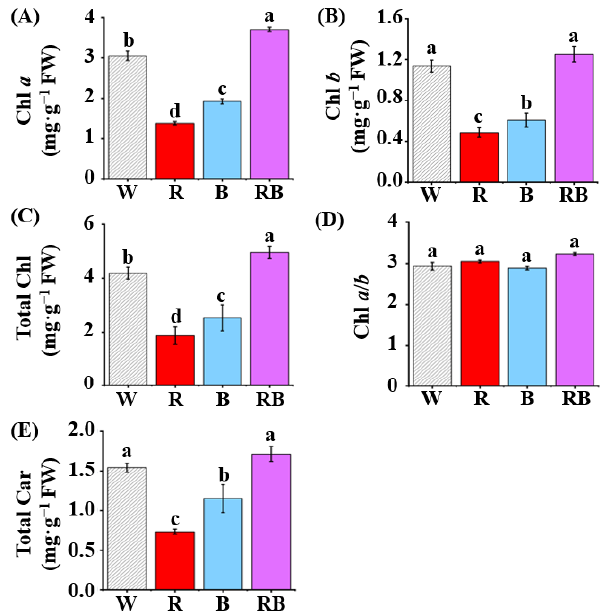
Figure 3. Effect of light quality on contents of chlorophyll a ( A ) and chlorophyll b ( B ), total chlorophyll ( C ), chlorophyll a / b ratio ( D ), and content of total carotenoids ( E ) in leaves of C. triste plantlets after four weeks of culture: The light qualities used were W, white LED; R, red LED; B, blue LED; and RB, combined red and blue LEDs in a 1:1 ratio. The results were expressed as means ± standard errors ( n = 3). Different letters indicate significant differences ( p < 0.05) by the Tukey’s multiple range test. 3.3. Effect of Light Quality on Parameters of Chlorophyll a Fluorescence in Leaves The OJIP method is considered an indicator of the state of the photosynthetic electron transport processes [61]. The OJ, JI, and IP phases represent the reduction of the acceptor side of PS II, of the plastoquinone (PQ)–pool, and of the acceptor side of PS I, respectively [40–42]. In this study, each step in OJIP curves exhibited a different response to light qualities (Figure 4). The fluorescence intensities were higher in the OJ phase under R. However, it showed the weakest signal in IP phase under R. RB induced lower fluorescence intensity in the OJ phase. For W and B, there was no significant difference in OJIP curves (Figure 4). For parameters of chlorophyll a fluorescence, light quality influenced the minimum fluorescence (F 0 ) but not the maximum fluorescence (F M ) in C. triste leaves ( p < 0.05, Table 3). It was observed that the F 0 was appreciably higher in leaves of plantlets grown under R than that in plantlets grown under RB ( p < 0.05, Table 3). The lowest electron transfer activity (F M /F 0 ) was also observed in plantlets grown under R ( p < 0.05, Table 3). The maximum quantum efficiency of PS II photochemistry (F V /F M ) and the actual quantum yield of PS II (F V /F 0 ) were significantly reduced with R ( p < 0.05), which were decreases of 3.5% and 16.5% respectively, compared to the maximum value (Table 3). The M 0 reflects the approximate initial slope of the fluorescence transient, and S M is the normalized total complementary area. There was a great increase in the M 0 value of plantlets grown under R ( p < 0.05). The values of S M decreased in plantlets grown under W and R. In leaves of plantlets grown under RB, the lowest M 0 and highest S M values were observed ( p < 0.05, Table 3). In C. triste leaves, the values of the quantum yield of electron transport (φE 0 ) and the possibility of a trapped exciton moving an electron into the electron transport chain beyond Q A (ψ 0 ) were 10.9% and 7.5% lower, respectively, when grown under R than their corresponding highest values when grown under RB ( p < 0.05, Table 3). In contrast, the quantum yield of heat dissipation (φD 0 ) under R was approximately 18.8% higher than the lowest value (Table 3). Under R, specific energy fluxes per